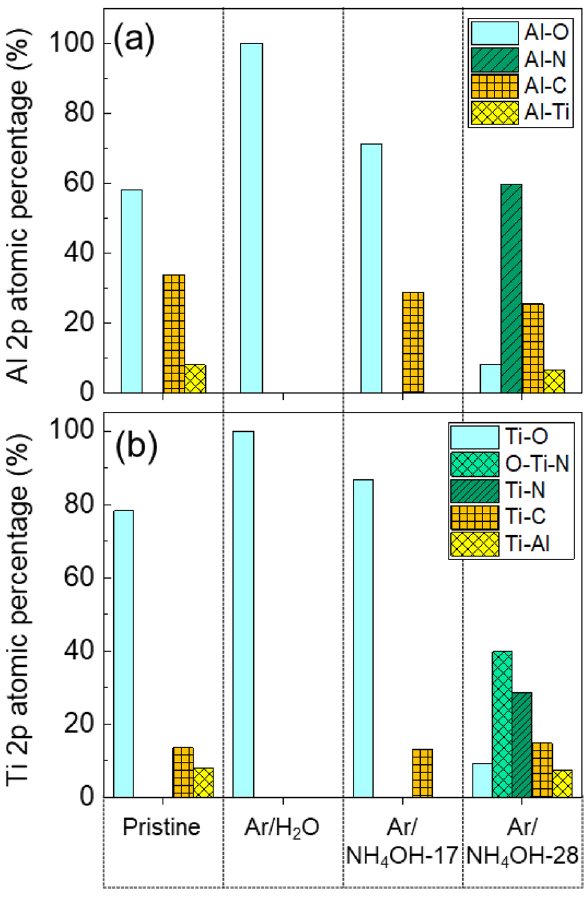
Figure 7. Chemical bond (Ti 2p and Al 2p) percentage of TiAlC surface before (pristine) and after exposure to Ar/H 2 O plasma and Ar/NH 4 OH plasmas at 100 W and 0.64